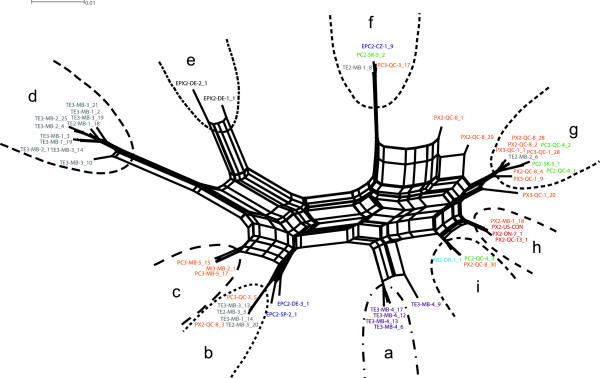
Phylogenetic network of 53 partial Pokey sequences from isolates of the Daphnia pulex complex. The network was constructed using the NeighborNet algorithm. Dashed lines delineate sequence groups presented in Table 
2. Colors represent species or hybrid state of isolates: red = D. pulex, light blue = D. arenata, grey = D. tenebrosa, black = European D. pulex, dark blue = European D. pulicaria, green = D. pulicaria, orange = putative pulex-pulicaria hybrids, purple = the isolate with D. tenebrosa mtDNA and a D. pulex nuclear genome.